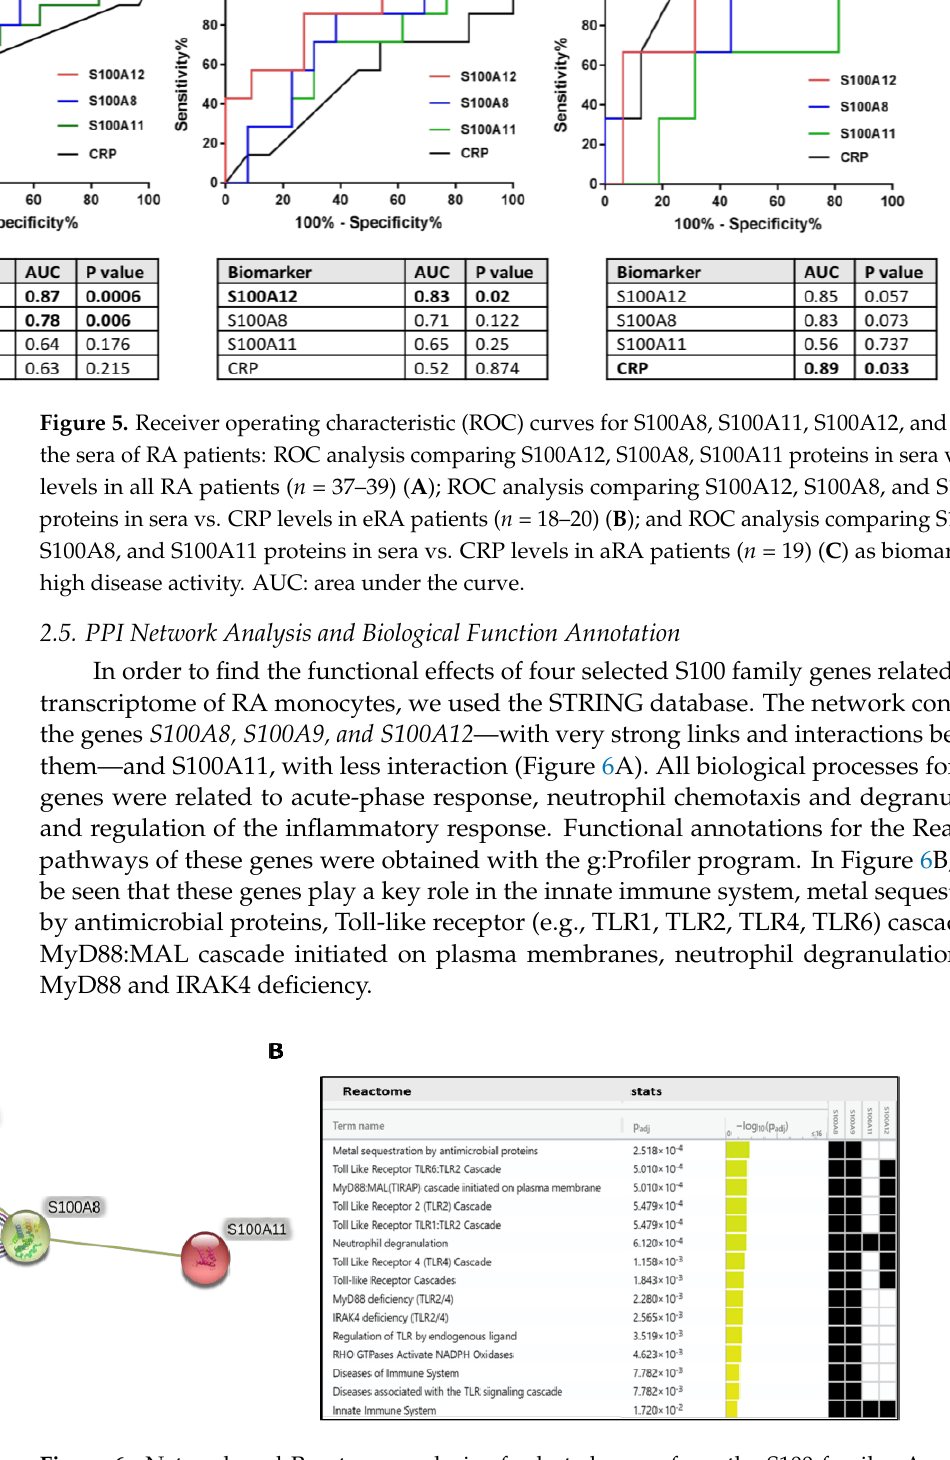
Figure 6. Network and Reactome analysis of selected genes from the S100 family: Association network analysis of the S100A8, S100A9, S100A11, and S100A12 genes was performed using the STRING program ( A ). Important pathways and processes in which the S100A8, S100A9, S100A11, and S100A12 genes were analyzed using the g:Profiler Reactome databases ( B ).